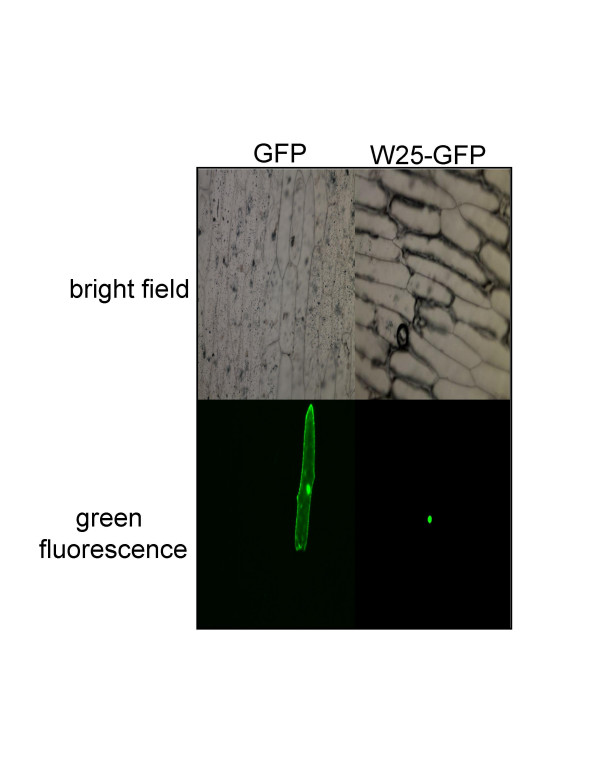
Localization of WRKY25 in vivo. WRKY25 was fused to GFP to yield W25-GFP; this chimeric protein was localized to the nucleus of onion epidermal cells. GFP alone was detected in both the nucleus and the cytoplasm due to its small size. Bright-field image of the onion epidermal cells are shown in the top panels.